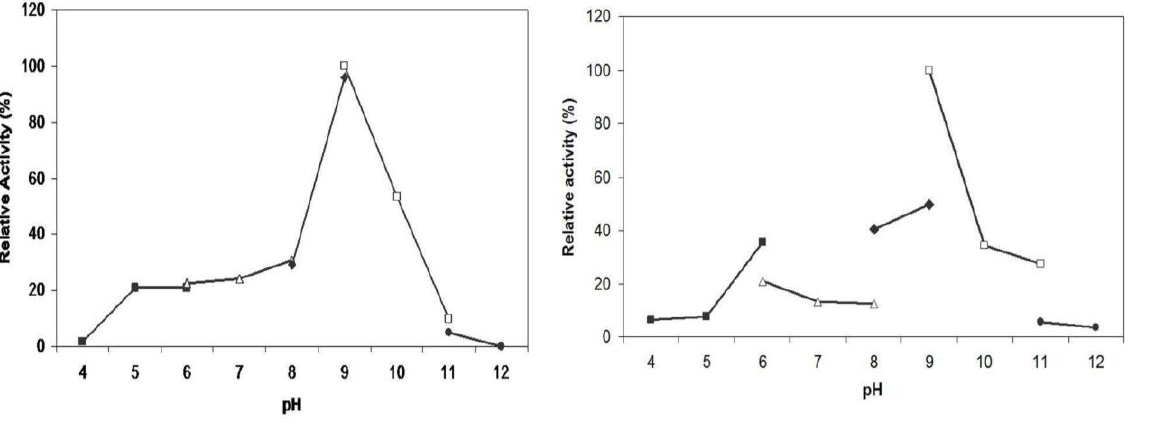
Figure 4. (a) pH profile of purified recombinant L2 lipase; (b) pH stability of purified recombinant L2 lipase. Symbols used are: (■) Acetate buffer; ( ∆ ) Potassium